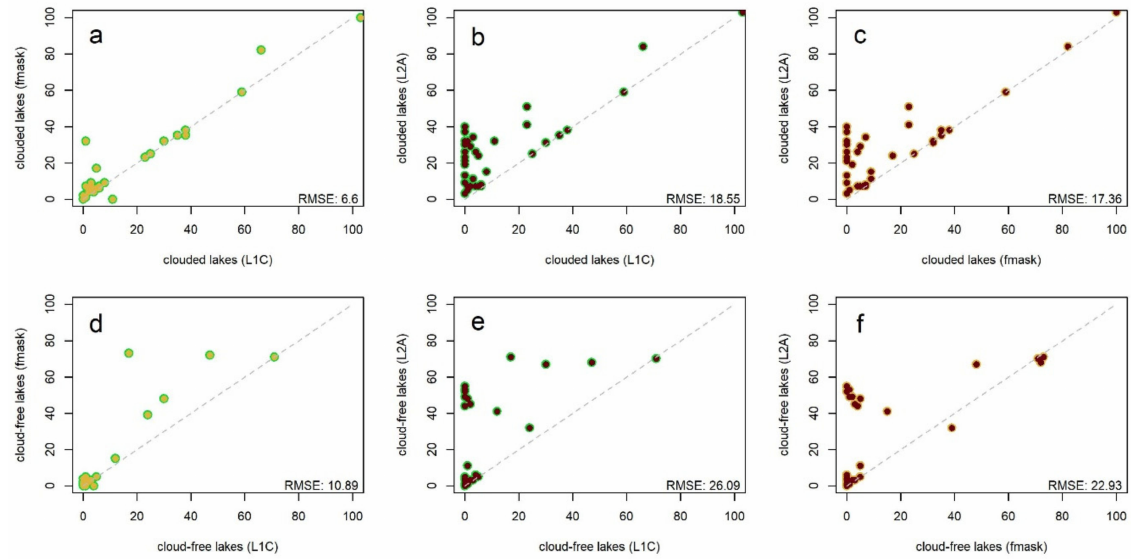
Figure A4. Relations for the clouded ( a – c ) and cloud-free ( d – f ) test data for the L1C-, fmask- and L2A cloud masks, with the respective RMSE. Color-code as displayed in Figure